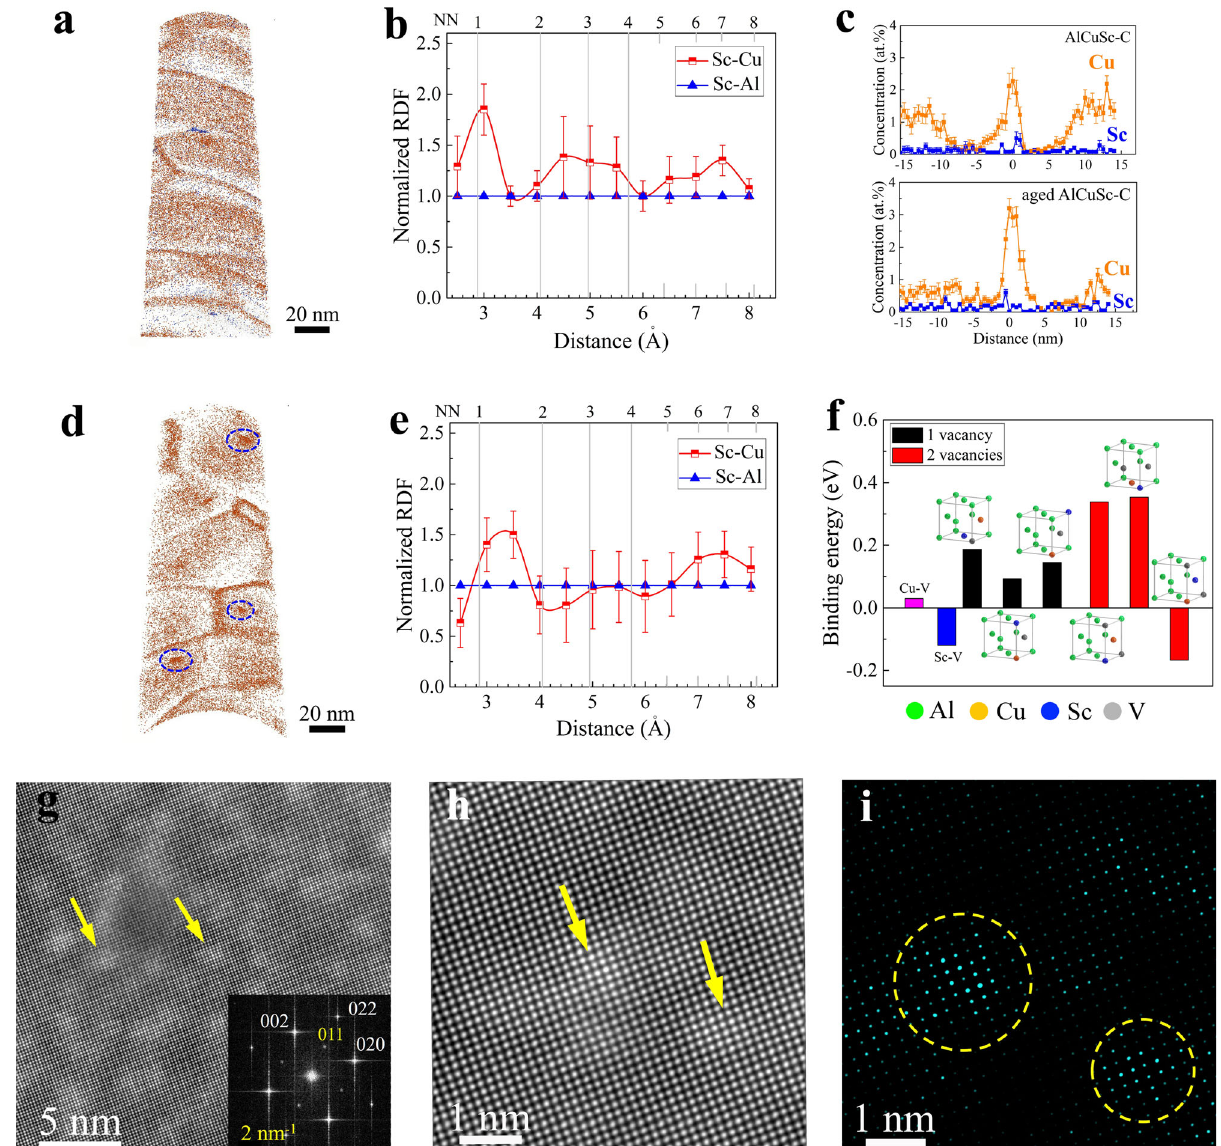
Fig. 4 Solute complexes in the AlCuSc-C alloy. a Representative APT reconstruction of the naturally-aged AlCuSc-C alloy, where Cu and Sc atoms are labeled with brown and blue colors, respectively. b Partial radial distribution function (RDF) analysis of the naturally-aged AlCuSc-C alloy showing the short-range ordering between Sc and Cu at the fi rst nearest neighbor (NN) location. The error bars are standard deviations of the mean. c 1-D concentration pro fi le of Cu across GBs in the AlCuSc-C alloy after natural aging and arti fi cial aging at 125 °C for 6 h. The error bars are standard deviations of the mean. d Representative APT reconstruction of the AlCuSc-C alloy aged at 125 °C for 6 h, where plate-shaped Cu atom clusters are marked by a dashed ellipse. e RDF analysis of the AlCuSc-C alloy aged at 125 °C for 6 h. The error bars are standard deviations of the mean. f Binding energy of the Cu- Sc-X vacancy complex (X = 1, 2) calculated by DFT. g High-resolution HAADF-STEM image viewed along <100> Al of the AlCuSc-C alloy, inset is the corresponding fast Fourier transform (FFT) pattern. h Atomic-resolution <100> Al HAADF-STEM image showing the solute complexes in the AlCuSc-C alloy. i Inverse FFT image showing the atom complexes enriched with Cu and